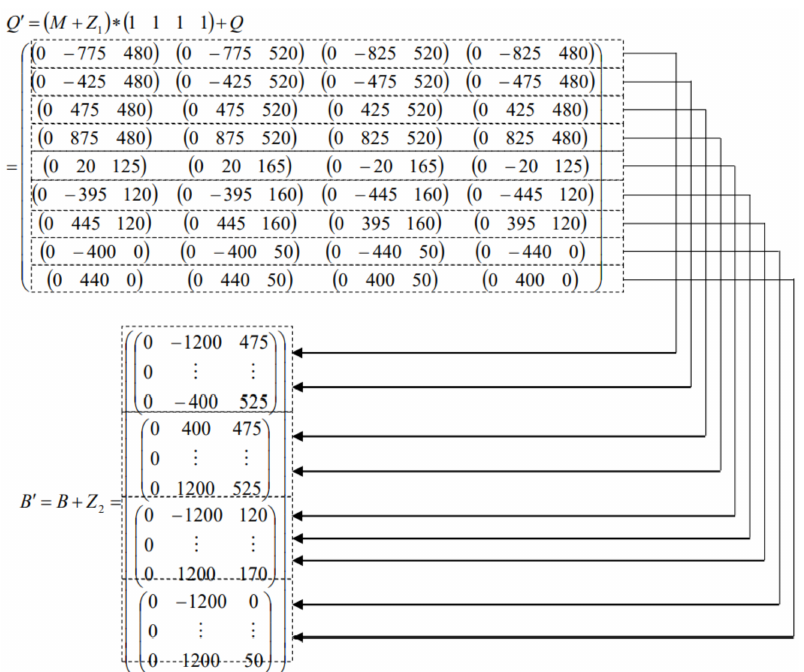
Figure 13. Confirmation of connection section relationship between modules and module reconfiguration.